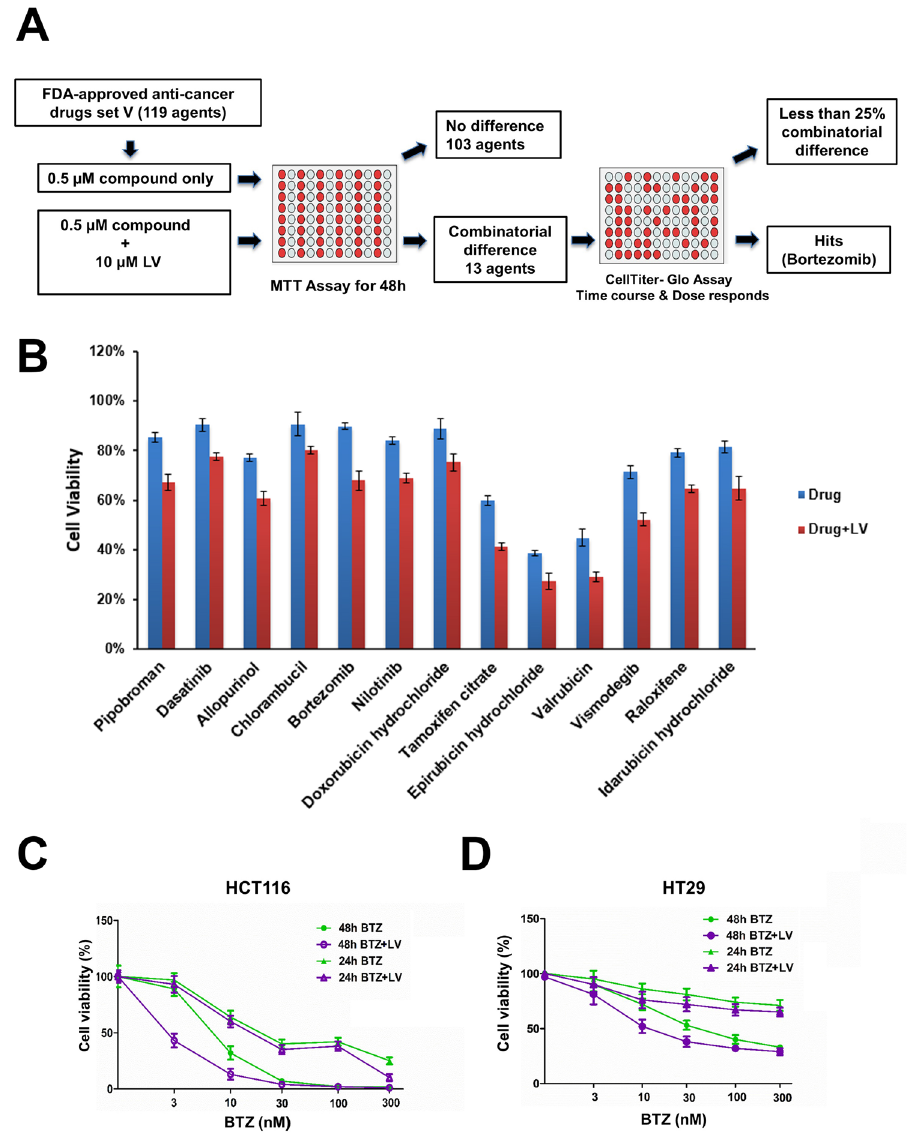
Figure 1. Bortezomib and leucovorin reduce cell viability of HCT116 and HT29 cells. (A) Schematic presentation of the screening of the Approved Oncology Drugs Set VI from NCI. (B) Cell viability of HCT116 cells treated with a single drug or with the addition of leucovorin. ( C,D) Percent viability of HCT116 ( B ) and HT29 ( C ) cells upon treatment with the combination of bortezomib (BTZ, 3 nM to 300 nM) and leucovorin (LV, 10 µ M) compared to those treated with bortezomib alone for 24 h and 48 h. Cell viability was determined by CellTiter-Glo assays ( C and D